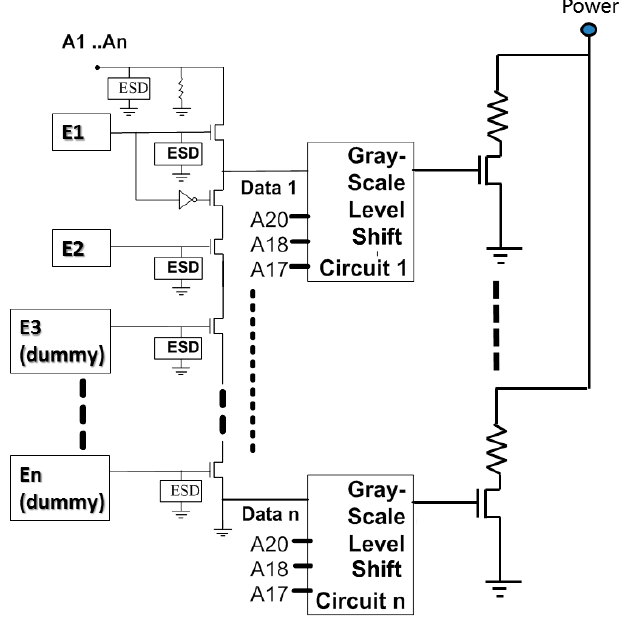
Figure 4. Driver array cell.